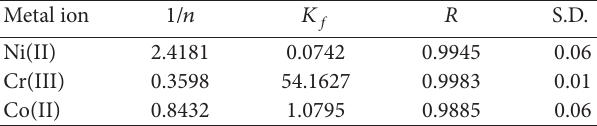
T 3: Freundlich isothermal parameters the biosorption of Ni(II), Cr(III), and Co(II) using Acalypha hispida leaf.